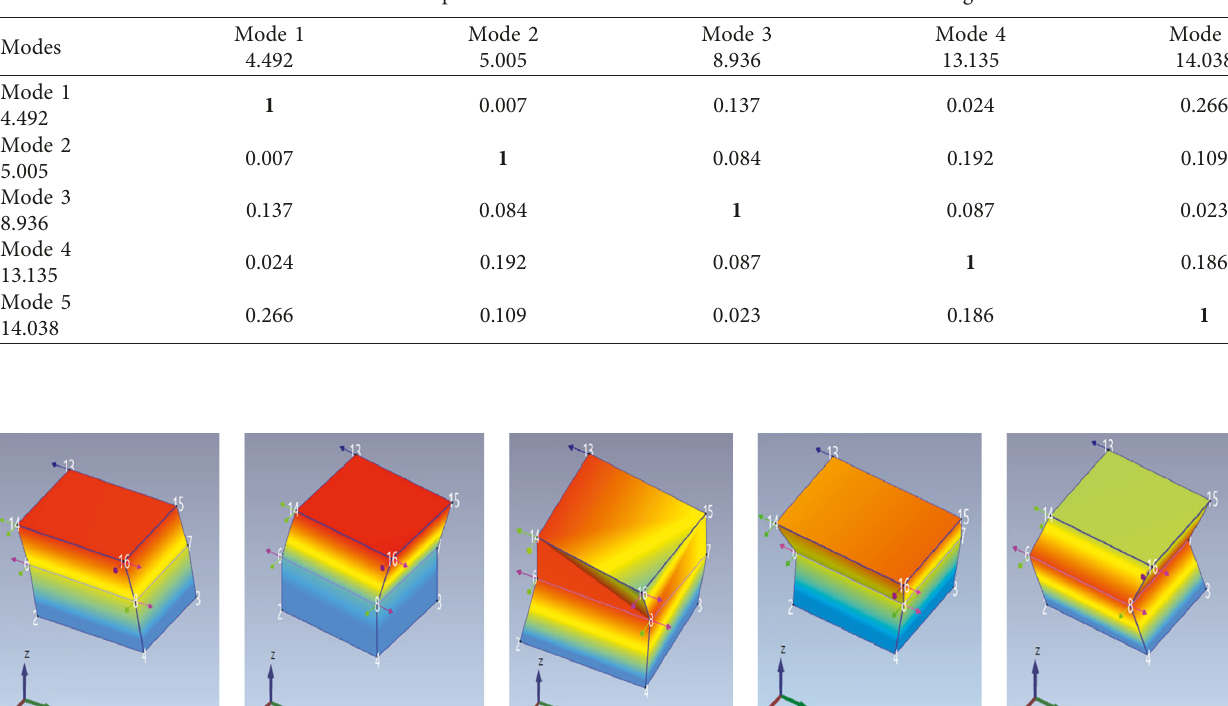
Figure 11: (a) 2D and (b) 3D presentation of MAC values of House 3 in G¨or¨ukle Table 3: Numerical presentation of MAC values of House 3 in G¨or¨ukle village.